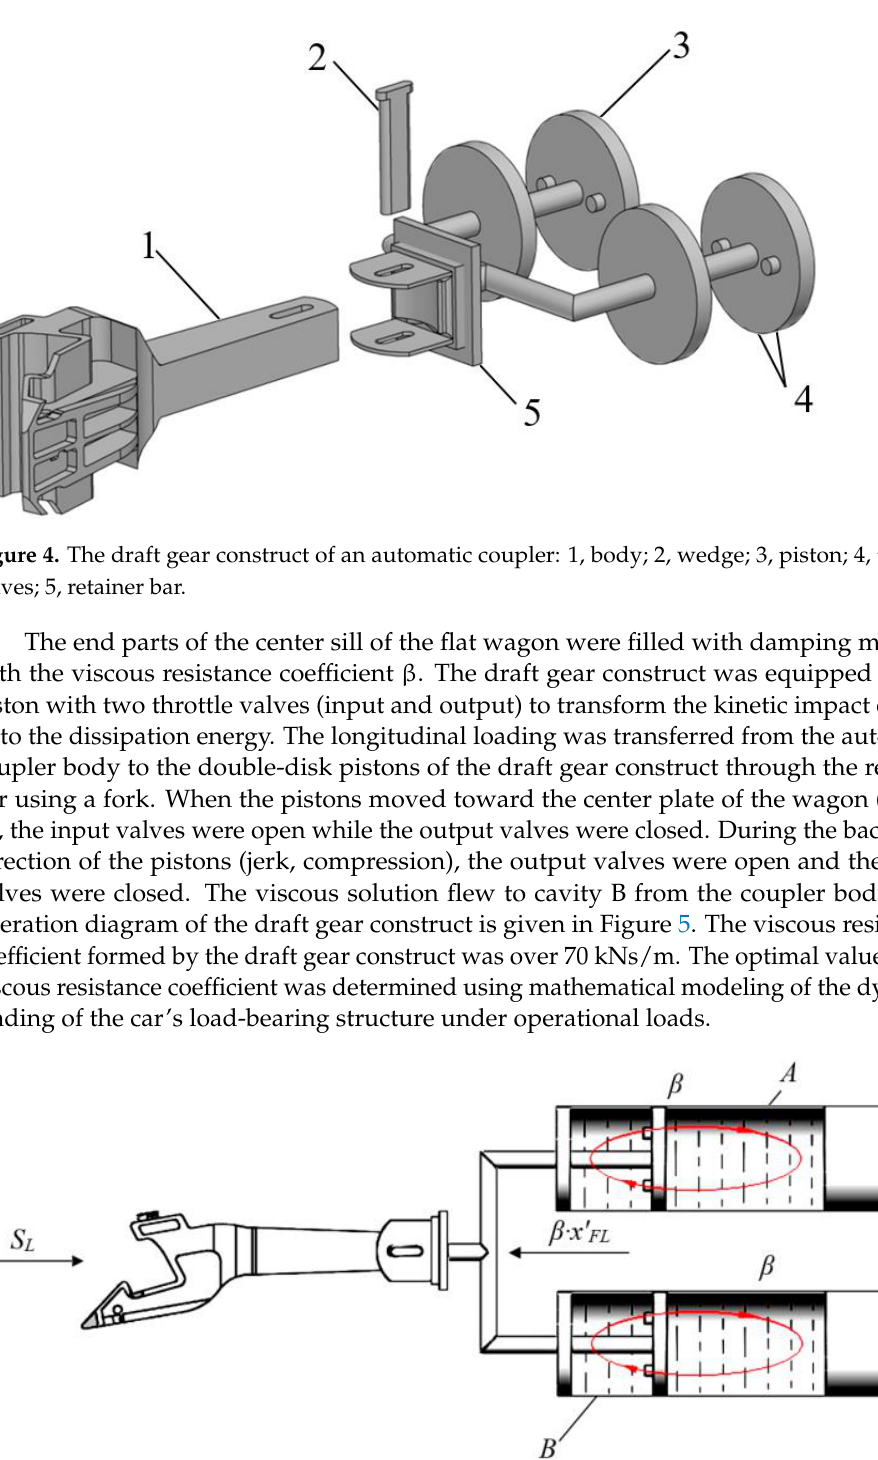
Figure 5. The operational diagram of the draft gear construct.